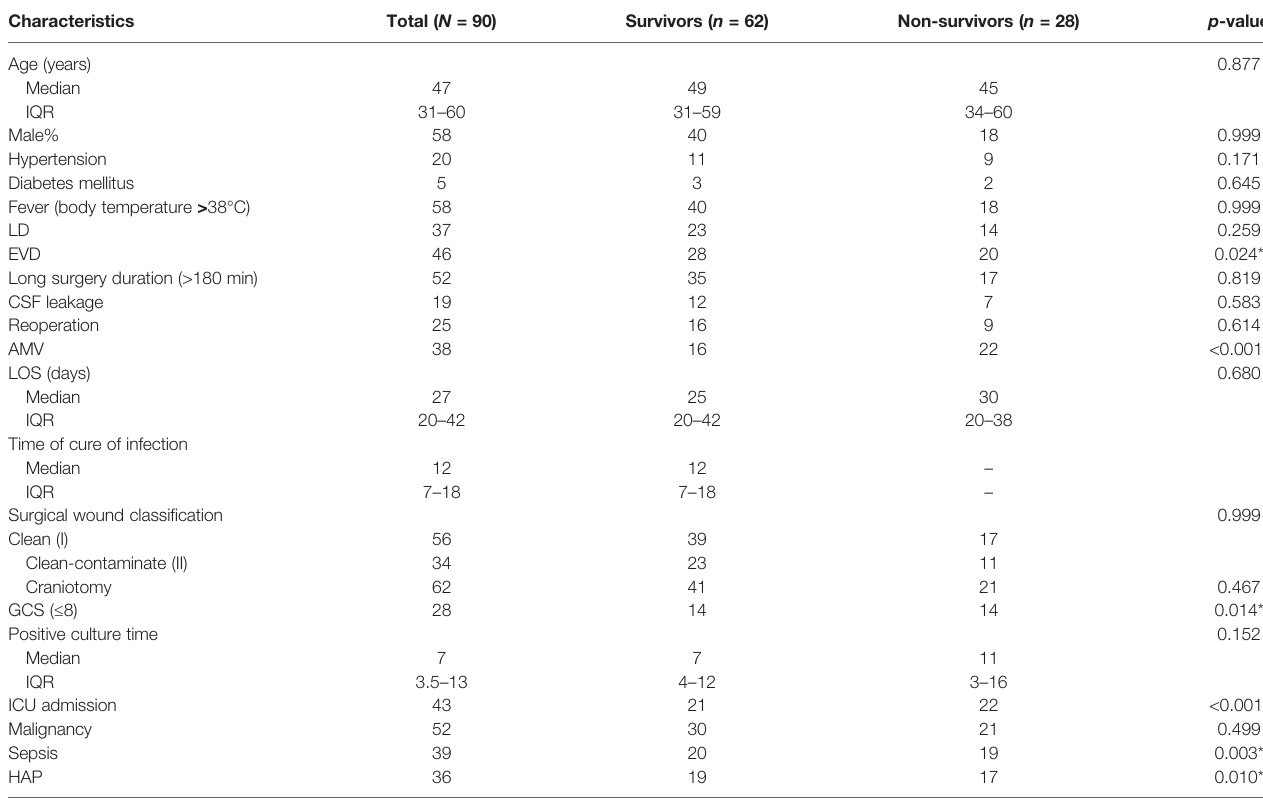
TABLE 1 | Clinical characteristics and univariate analysis of survivors and non-survivors.